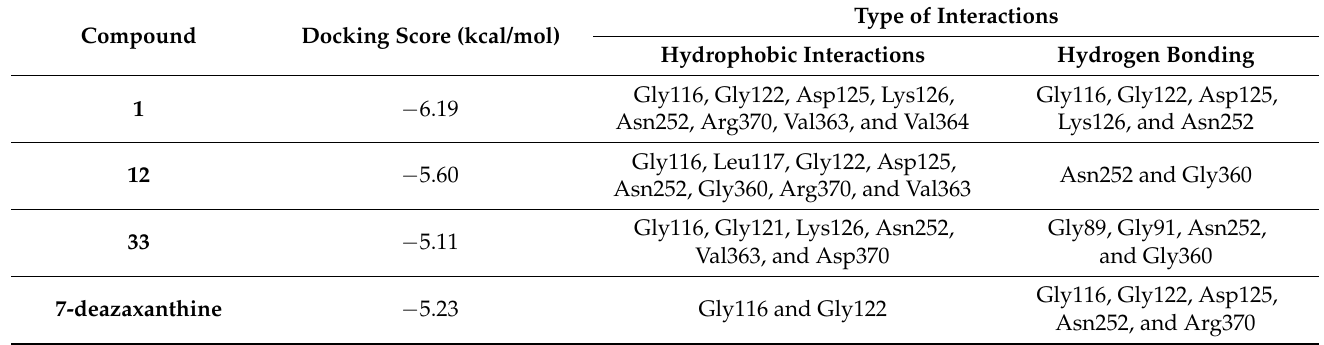
Table 3. Detail of results of molecular docking studies including docking scores, type of interactions, and interacted